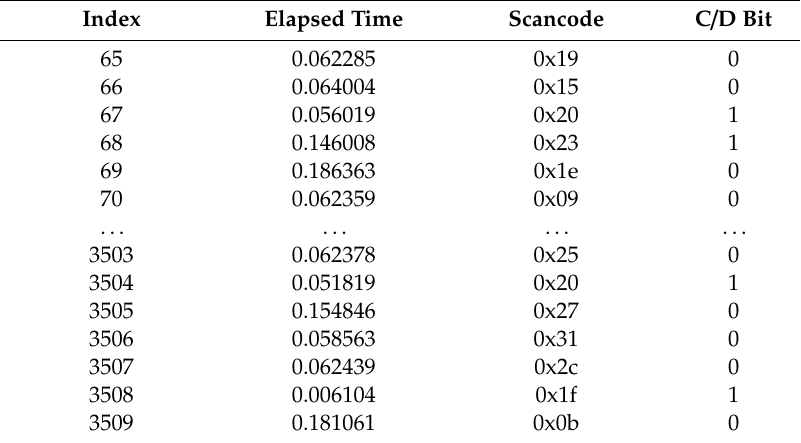
Table 2. Examples of collected scancodes.